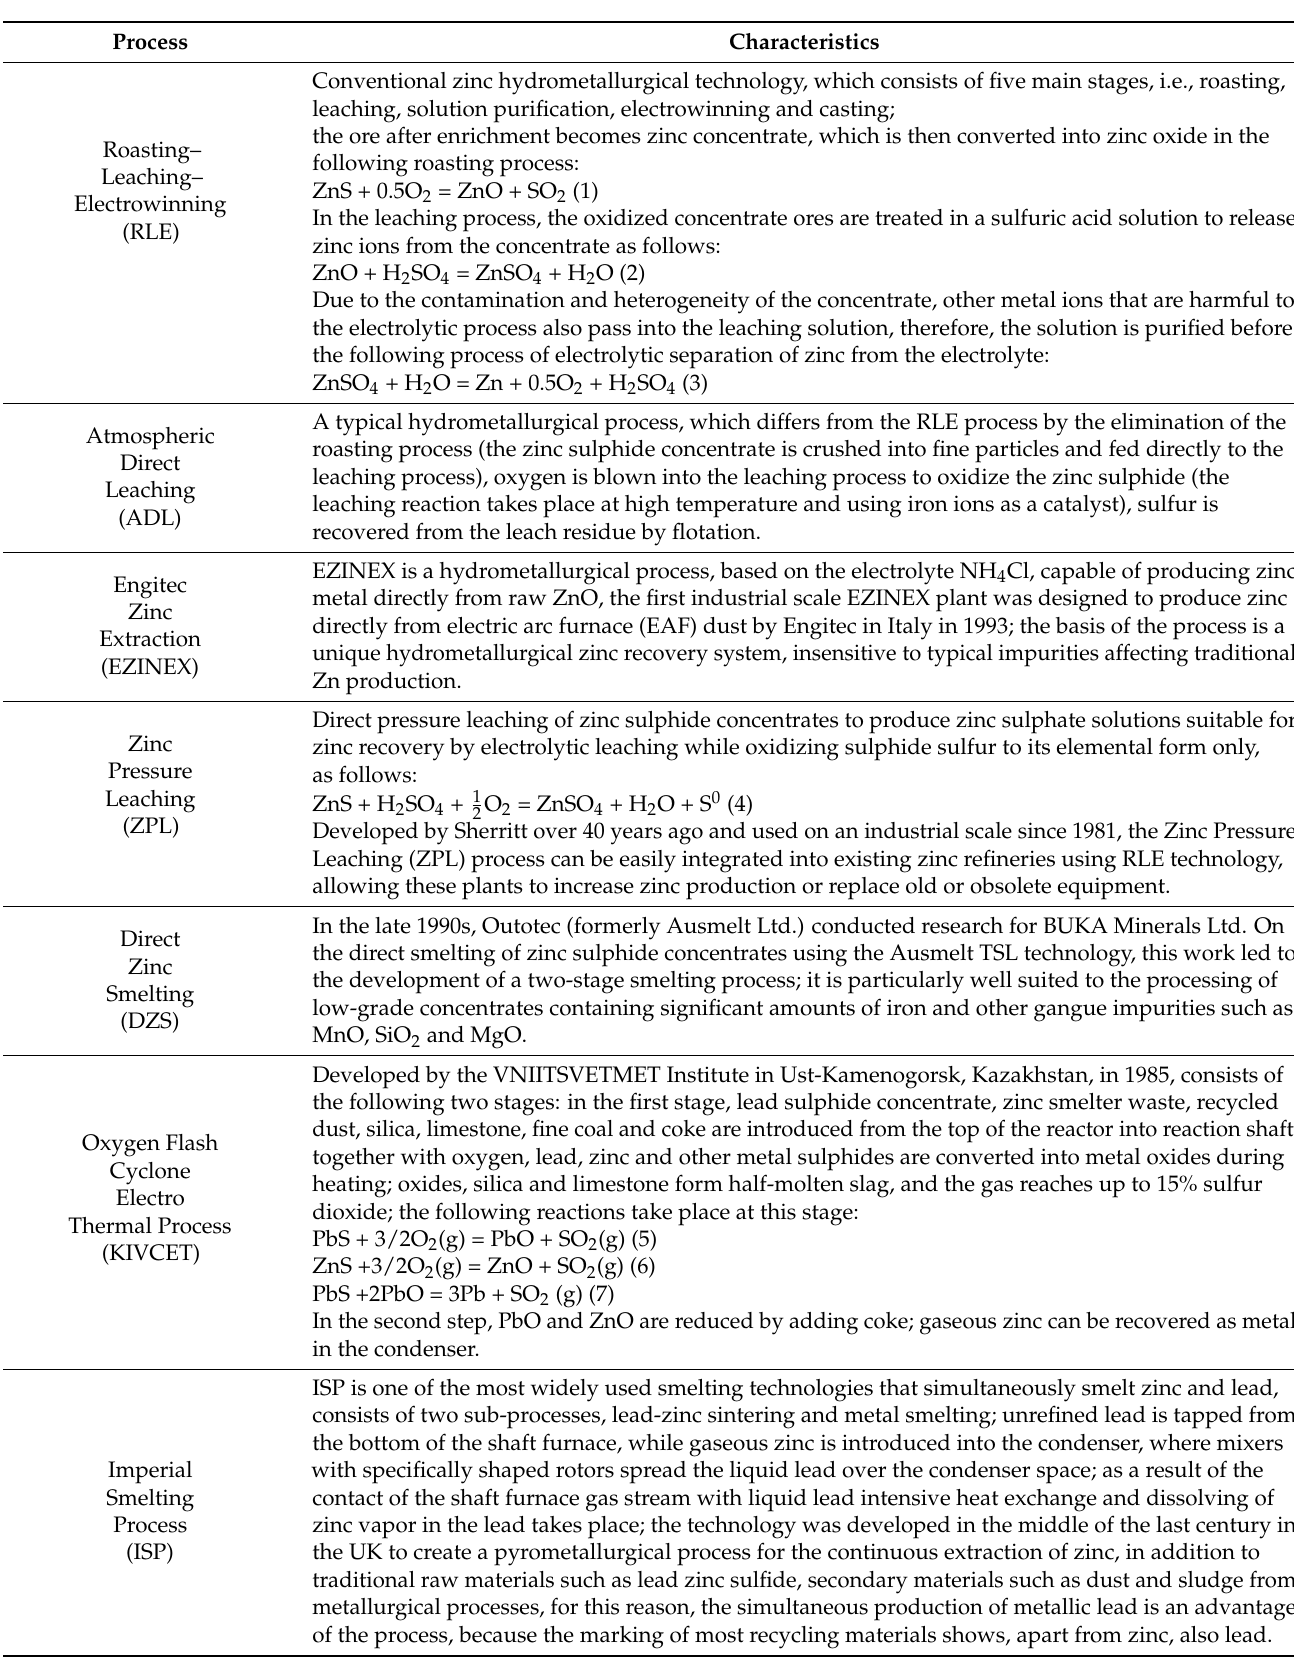
Table 5. Characteristics of basic methods of obtaining zinc from ores and concentrates, worked out based on data from